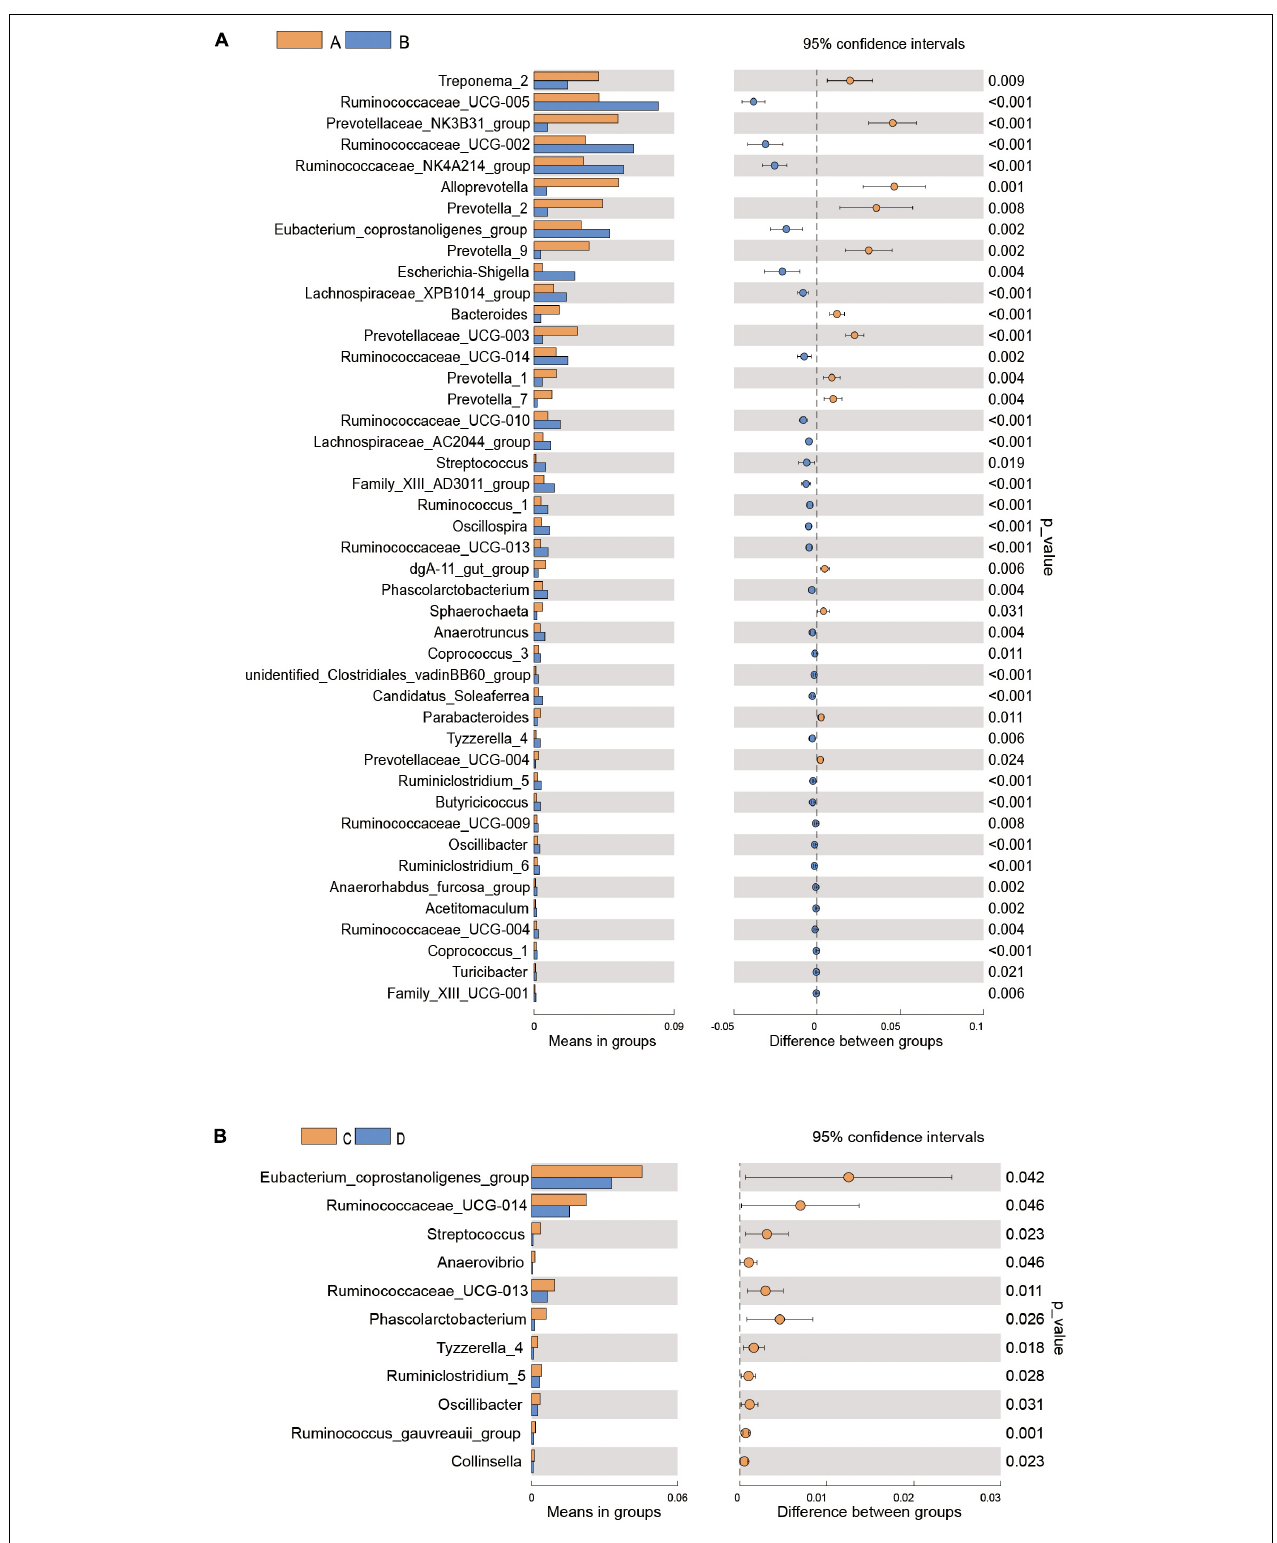
FIGURE 3 | T -test bar plot of significantly different gut microbial species in sows at genus level (A,B) . n = 6. A, C: sows with high productive capacity (HPC) at late pregnancy (LP) and early stage after parturition (EAP) separately; B, D: sows with low productive capacity (LPC) at late pregnancy (LP) and early stage after parturition (EAP)